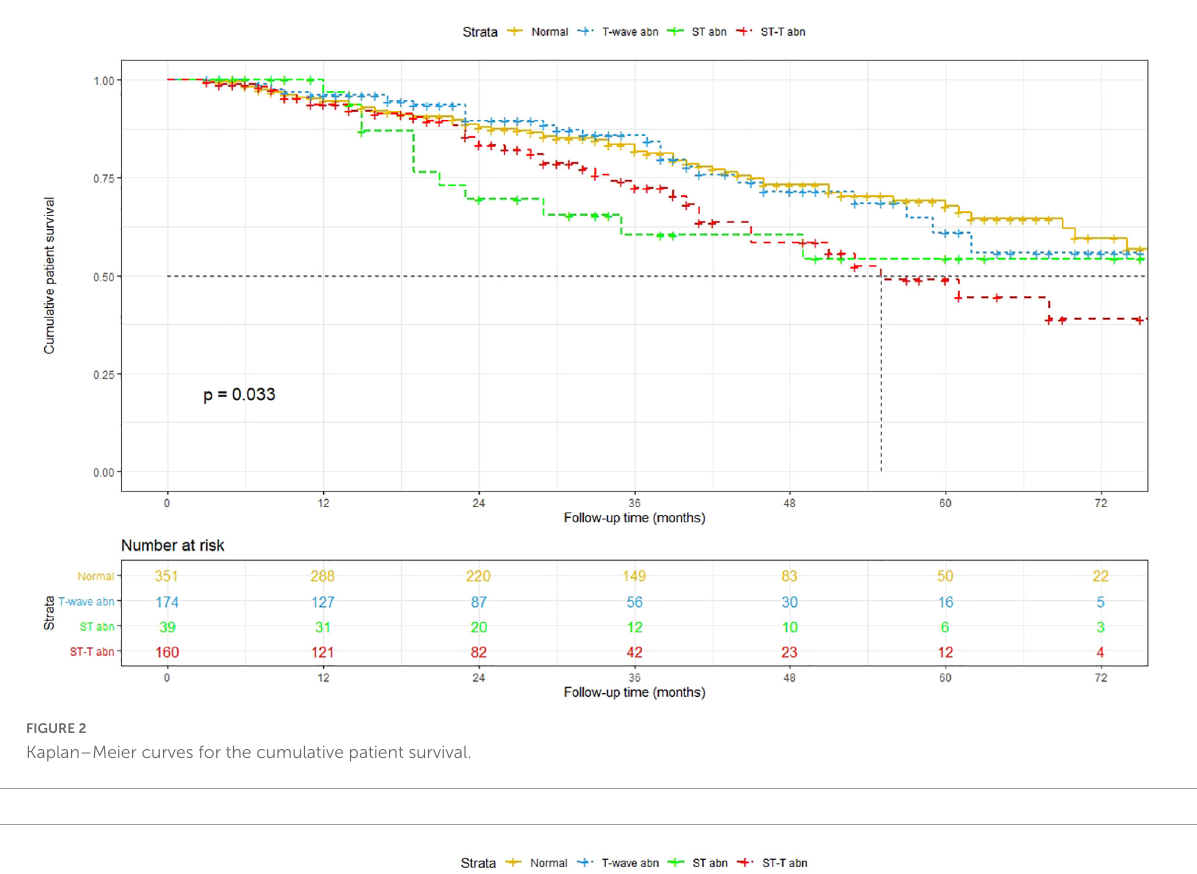
FIGURE2 Kaplan–Meier curves for the cumulative patient survival.